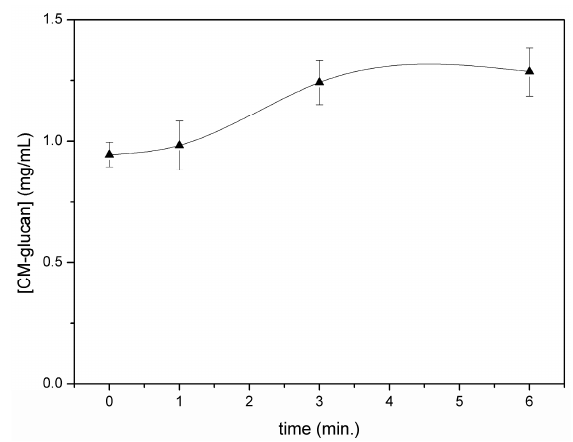
Figure 4. CM-glucan residual amount after various nebulization times of resveratrol/CM-glucan